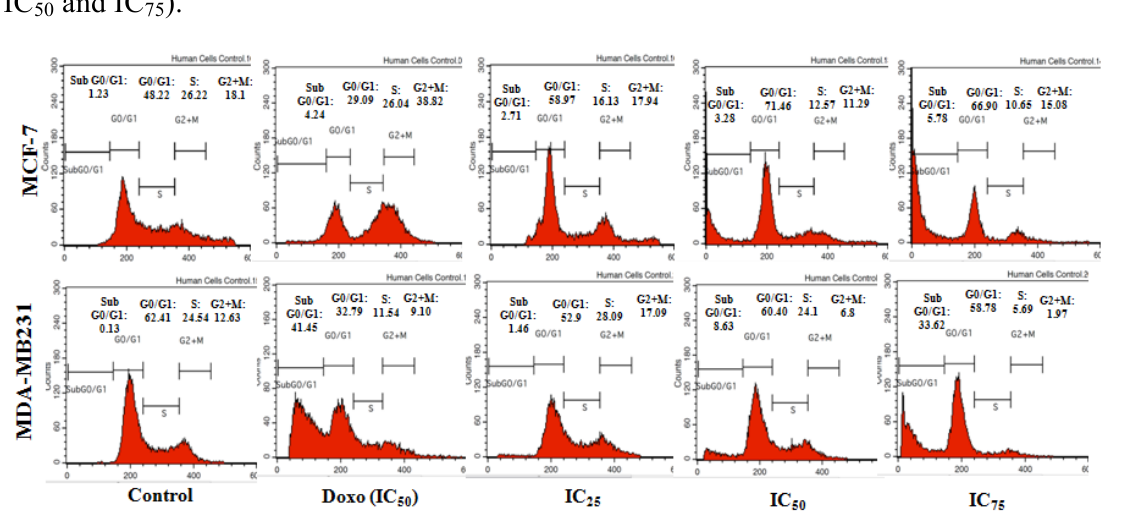
) and three different concentrations of BHAQ (IC 50